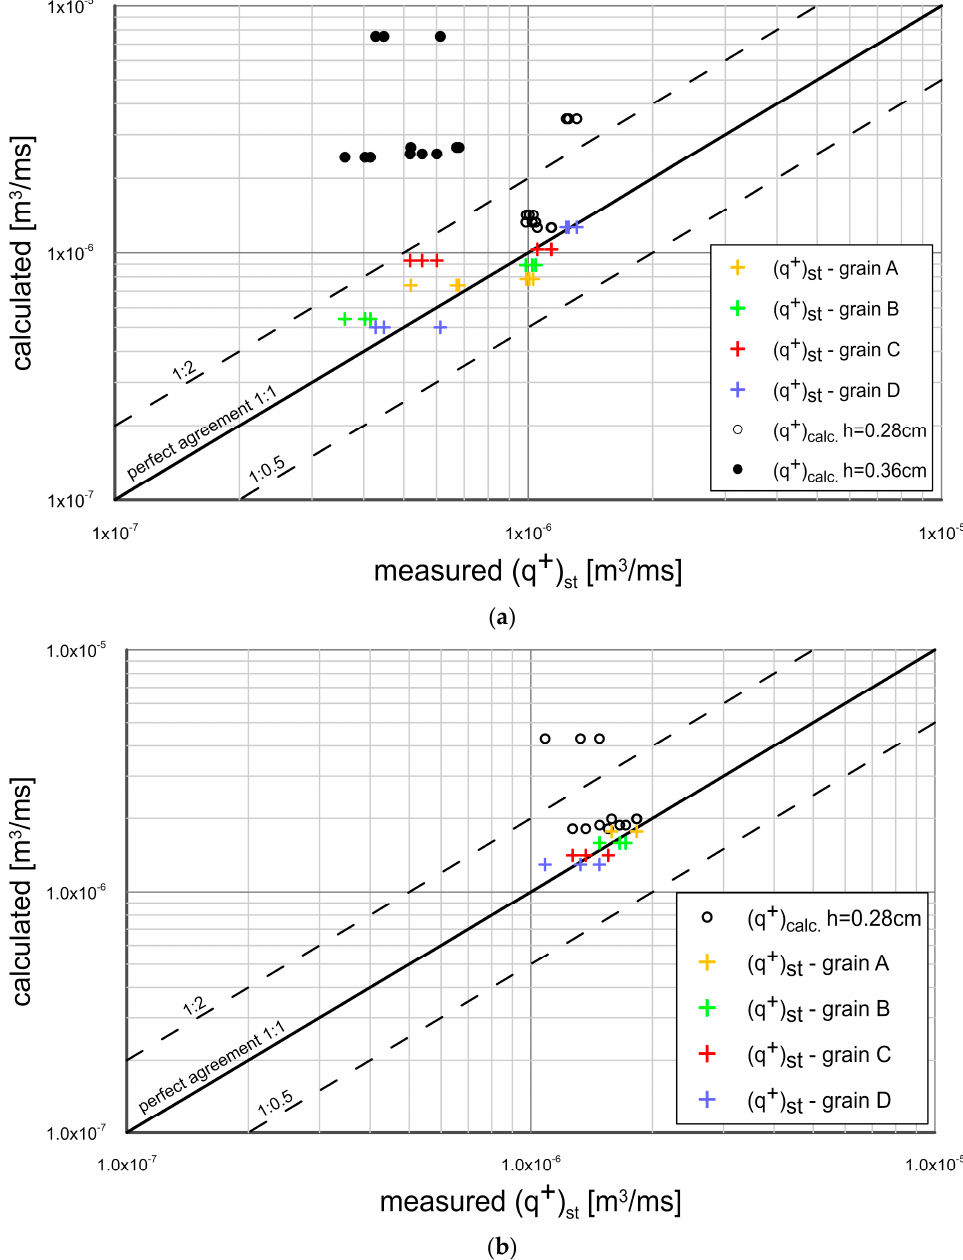
Figure 9. Comparison of calculation and measurements results q + between flat ( a ) and sloped bed ( b ) cases during the crest.